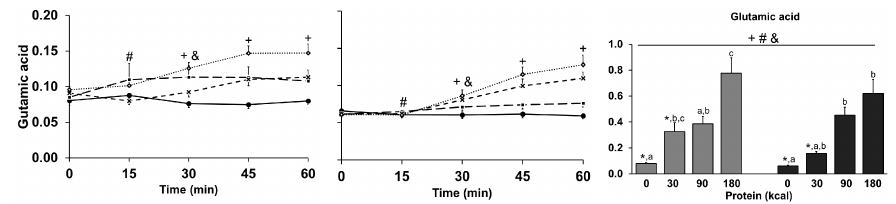
Figure 4. Mean (±SEM) and area under the curve concentrations of plasma total amino acids, essential amino acids (histidine, isoleucine, leucine, lysine, methionine, phenylalanine, threonine, tryptophan, and valine), branched chain amino acids (isoleucine, leucine, and valine), and individual amino acids ranked in order of highest to lowest prevalence of amino acids in the whey protein hydrolysate, in healthy younger ( n = 10; n = 9 for histidine) and older ( n = 10) men during intraduodenal infusions of saline (control; solid line with closed circles) and whey-protein loads of 30 kcal (7.5 g protein; dashed line with closed squares), 90 kcal (22.5 g protein; dashed line with crosses), and 180 kcal (45 g protein; dotted line with open diamonds). Main effect of protein-load, age, and interaction effects were determined using a mixed-effect model with baseline concentrations as a covariate and post-hoc Bonferroni correction; statistical significance was accepted at p < 0.05. + p < 0.05 Effect of protein-load.